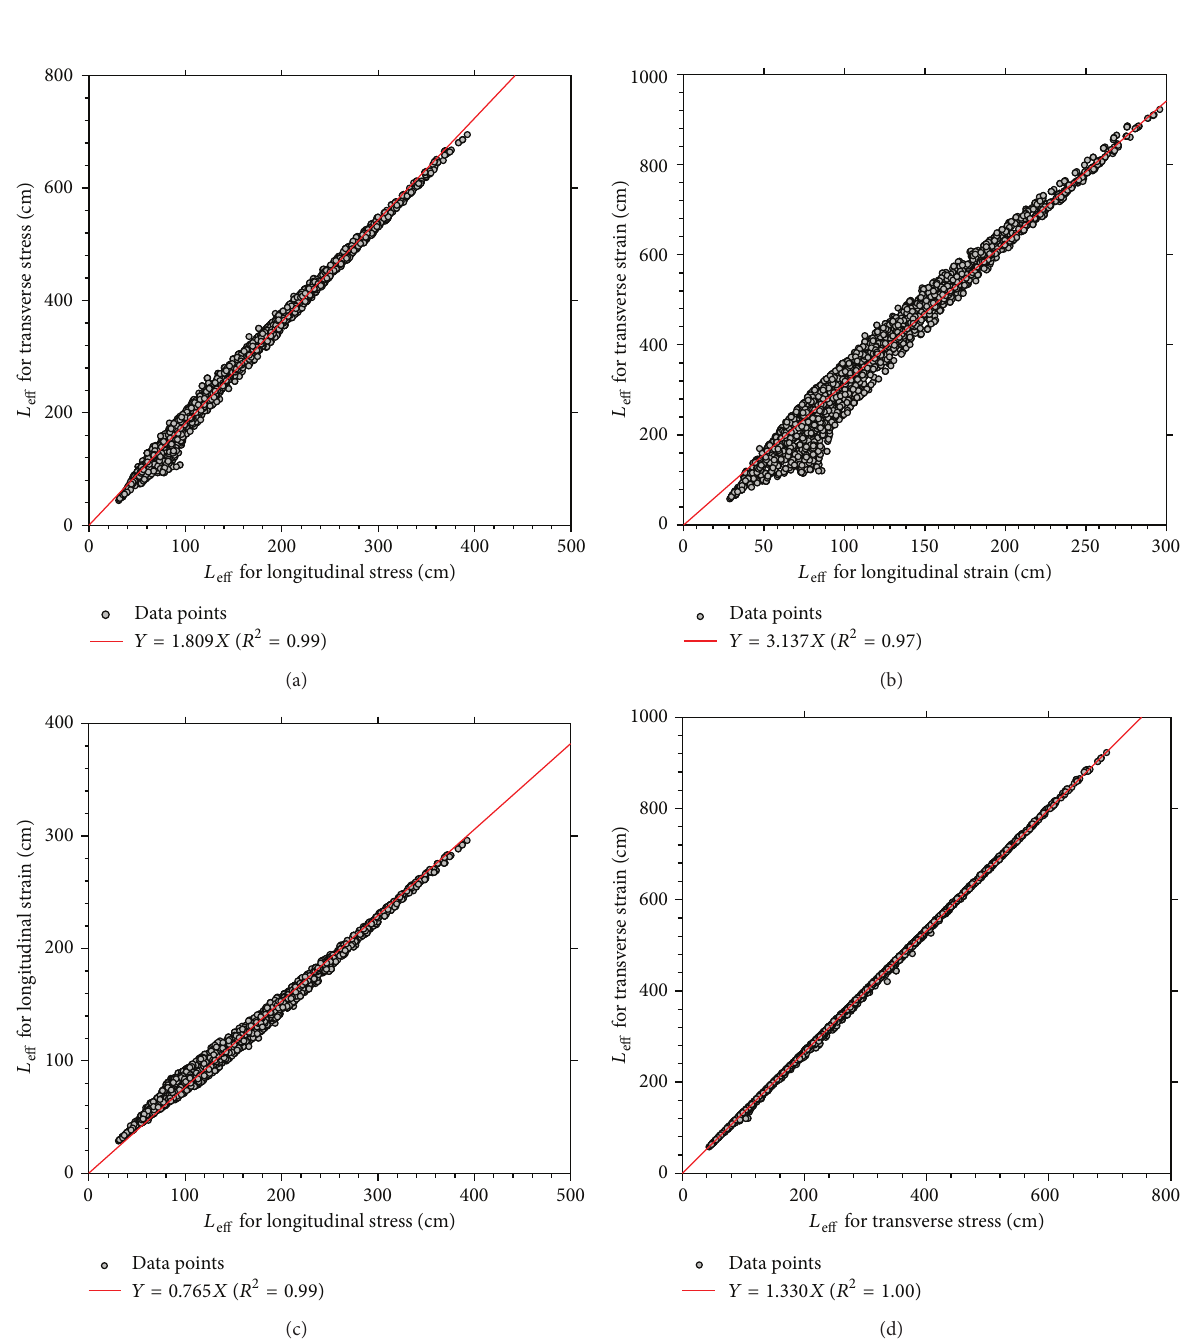
Figure 4: Relations between effective length of stress and strain pulses in longitudinal and transverse